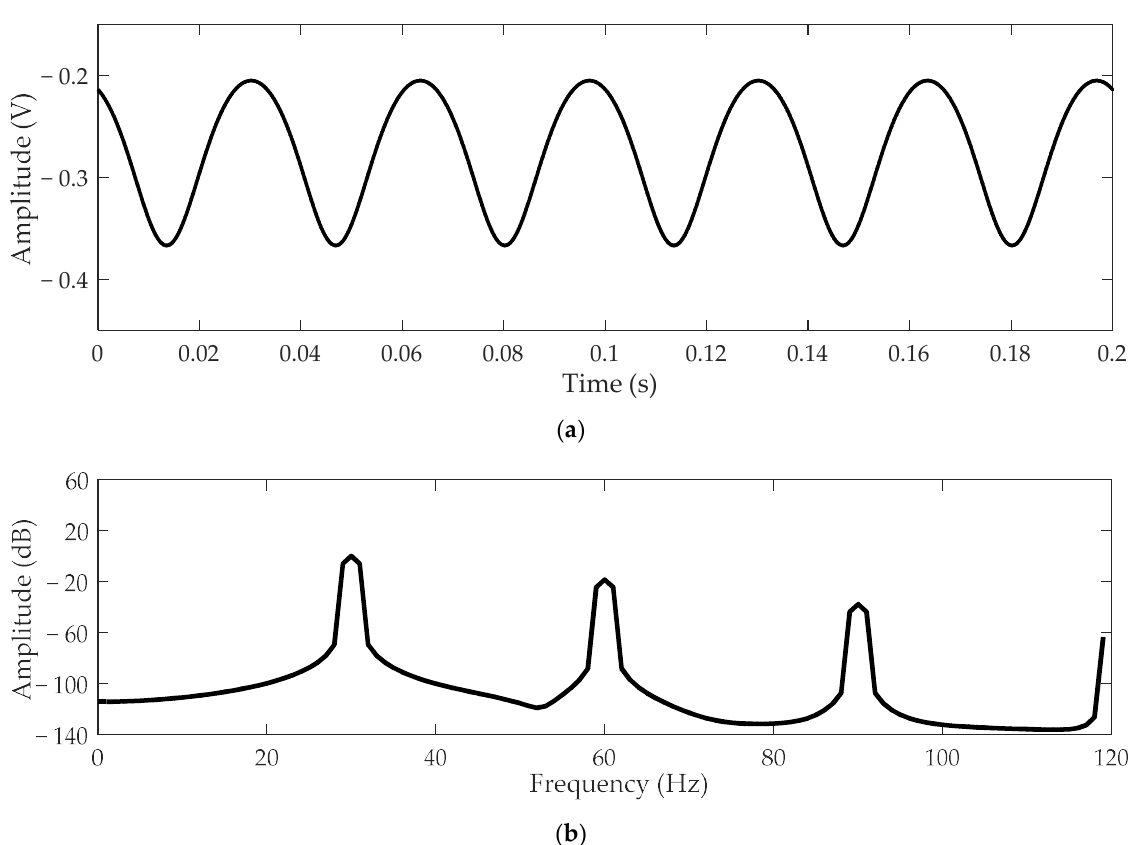
Figure 3. The simulation waveform of the output signal V o : ( a ) time-domain waveform; ( b ) frequency-domain wave- form.